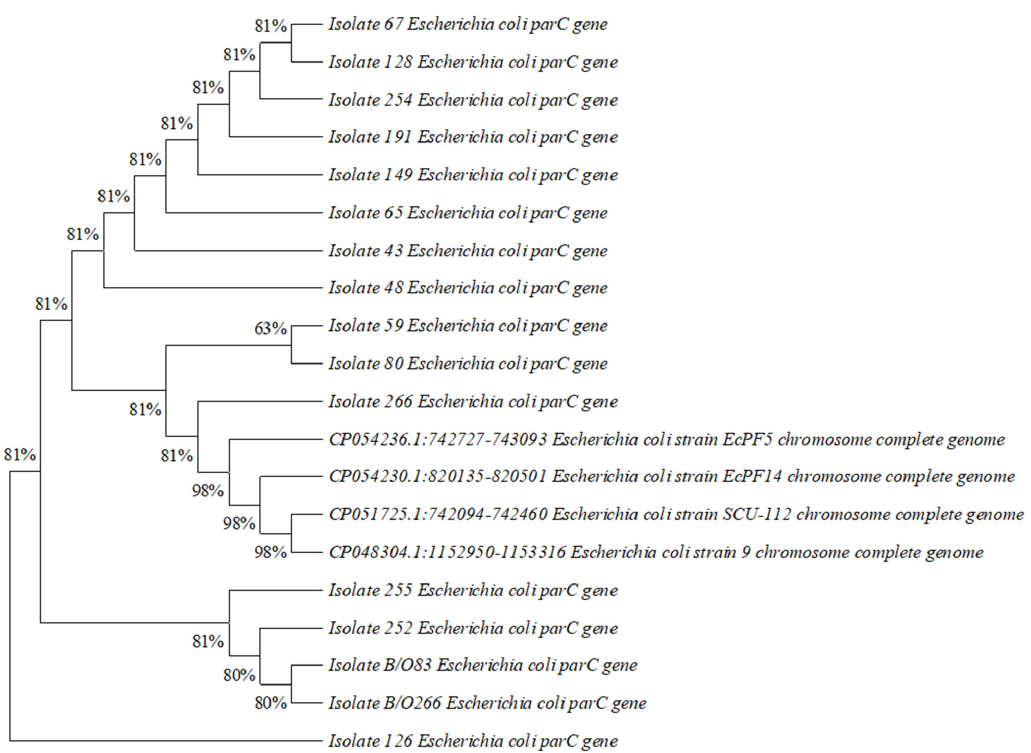
Figure 2. Phylogenetic tree based on DNA topoisomerase IV ( parC ) sequences illustrating the evolutionary distance between 16 isolates of Escherichia coli from 14 mothers and 2 neonates and 4 strains of Escherichia coli with known pathotypes.